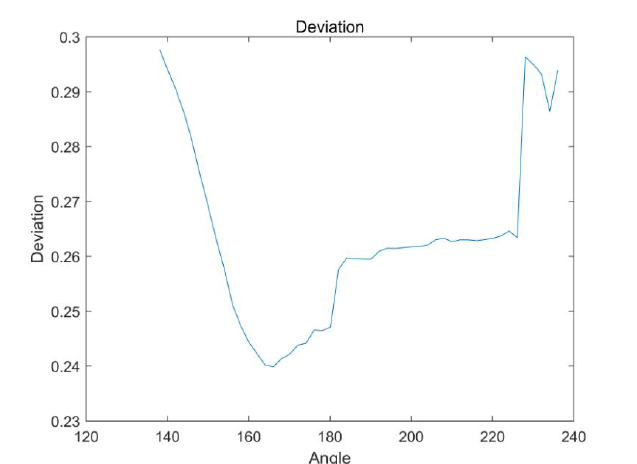
Figure 5. Original deviations for the primary tolerance